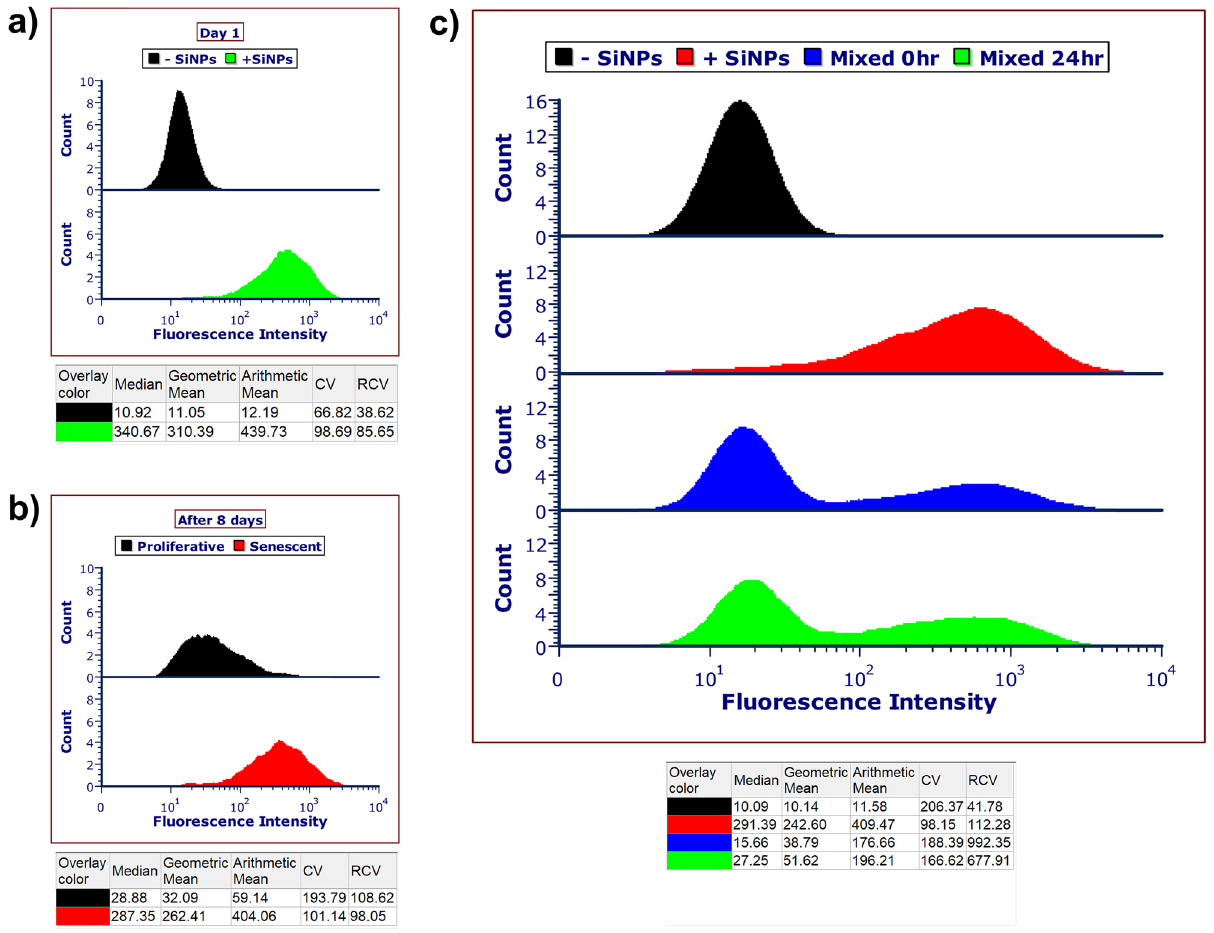
Figure 2. SiNP retention inside senescent cells and transfer between senescent cells is negligible. ( a ) Proliferative WI-38 fibroblasts were incubated with 25 μg/ml SiNPs for 80 min. On day 1, the cells with SiNPs (+SiNPs) were analyzed by flow cytometry alongside control cells with no silica NPs (−SiNPs). ( b ) The +SiNPs cells from ( a ) were split into two treatment protocols for continued growth and senescence induction (see “Methods” section for details). After 8 days in culture, flow cytometry revealed senescent cells had retained their SiNPs while proliferative cells diluted their content with each cell division. ( c ) Representative